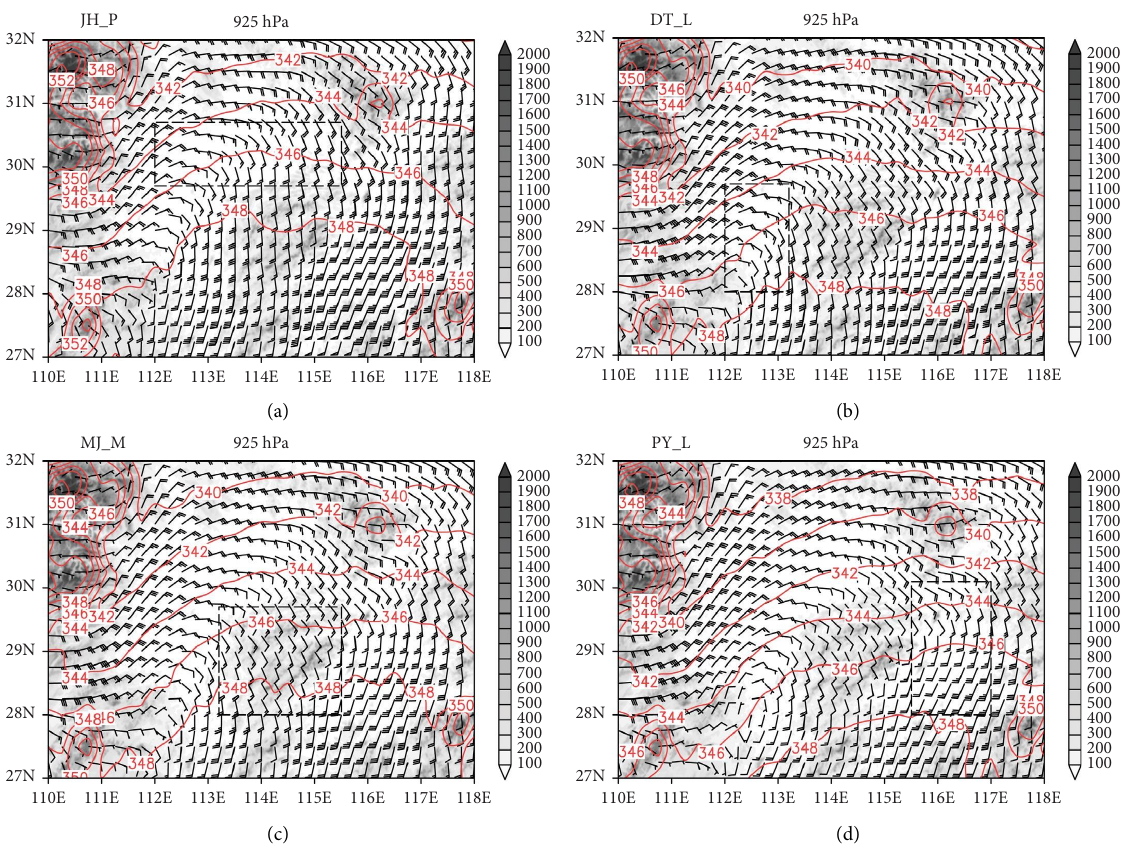
Figure 5: Synthesized wind (barb; m · s − 1 ; each bar for 1m · s − 1 ) and θ se (red solid line; K) at 925hPa when HHR events occur in diferent subregions (a) JH_P, (b) DT_L, (c) MJ_M, and (d) PY_L, respectively. Te black dashed line box is the respective HHR area, and the gray fll is the terrain altitude (m).